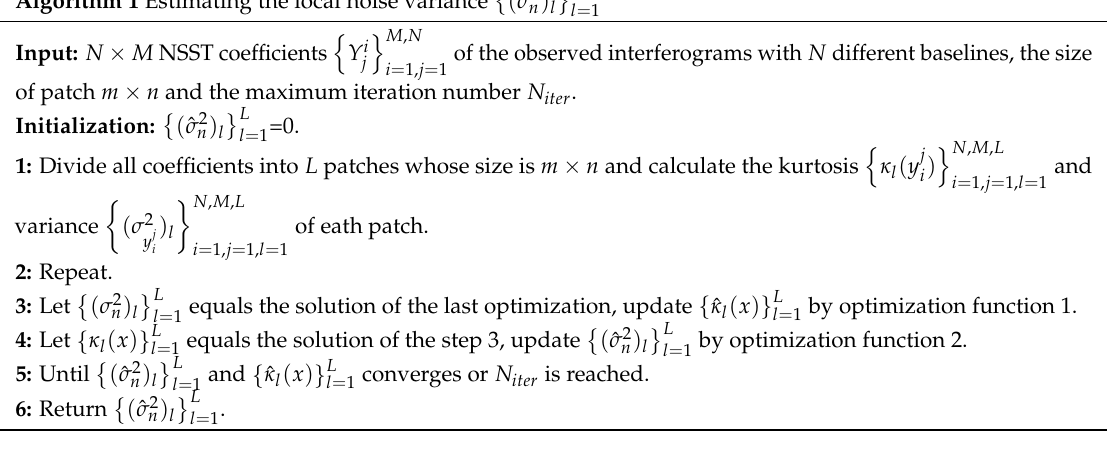
(cid:8) ( (cid:9) L ˆ σ 2 n ) l l =